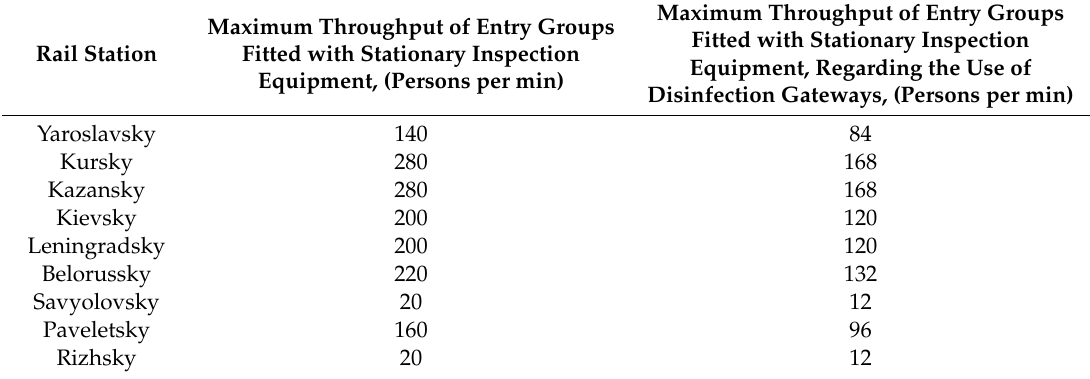
Table 6. Evaluation of the throughput of the entry groups, fitted with stationary screening equipment, at the rail stations in the city of Moscow, regarding the use of disinfection